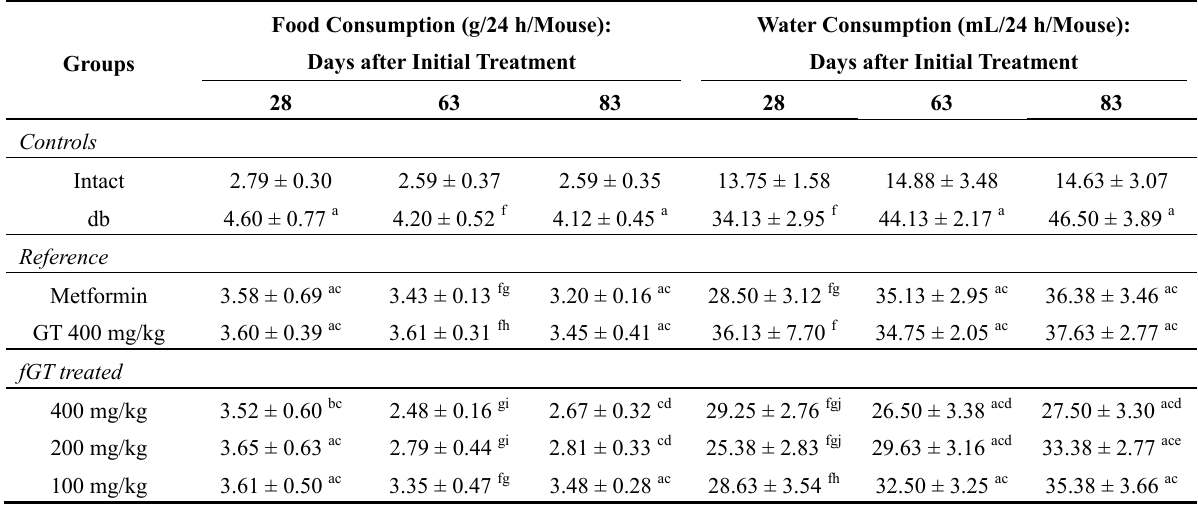
Table 1. Food and water consumptions in intact normoglycemic and db/db mice.